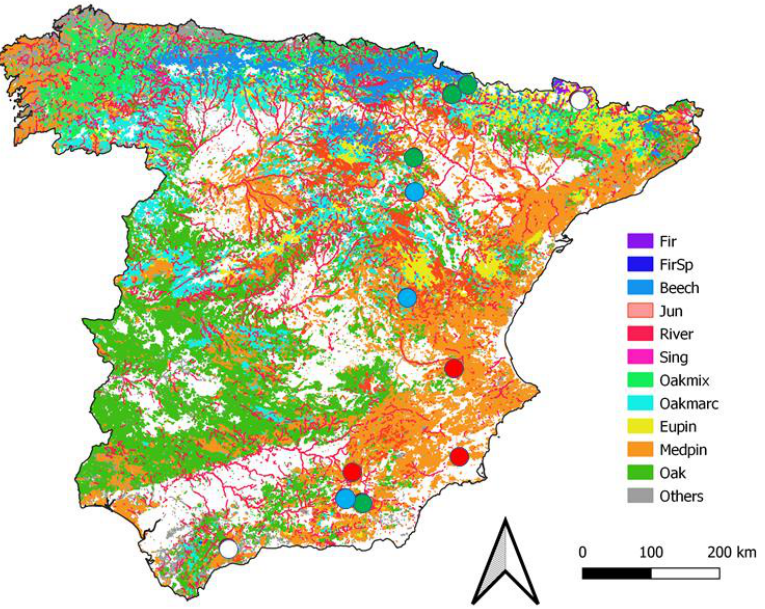
Figure 1. Distribution of Pinus thinning plots over the vegetation map of Spain over the layout of forest types presented in [38]. European beech forests (Beech), Oak and mixed broad-leaved species forests (Oakmix), Silver fir forests (Fir), Eurosiberian pine forests (Eupin), Marcescent oak forests (Oakmarc), Oak and cork oak forests (Oak), Mediterranean pine forests (Medpin), Juniper forests (Jun), Spanish fir forests (FirSp), River forests (River), Forests of birch, hollies, hazel, linden and aspen trees (Sing) and other forests non included in the other categories (Others). Pinus halepensis ( n = 3 plots, red), P. nigra ( n = 3 plots, blue) and P. sylvestris ( n = 4 plots, green), other lots of SilvaAdapt non included on this study ( n = 2, white).